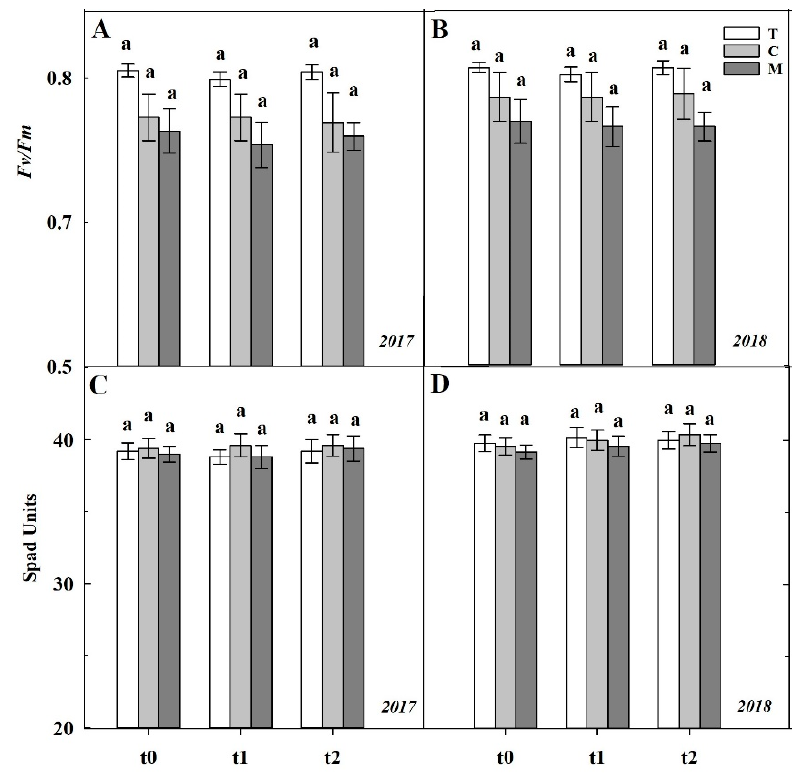
Figure 2. Maximum quantum yield of PSII ( Fv / Fm ) ( A , 2017; B , 2018) and chlorophyll content ( C , 2017; D , 2018) of V . vinifera with three different soil management practices: T (tillage; white columns), C (cover cropping; light grey columns), and M (mulching; dark grey columns). Measurements were conducted at full veraison (t0: 7 July 2017 and 17 July 2018), mid maturation (t1: 28 July 2017 and 15 August 2018), and full maturation (t2: 5 September 2017 and 17 September 2018). Data (mean ± SE, n = 10) were subjected to one-way ANOVA. Values with different letters are statistically different. (LSD test, p ≤ 0.05).